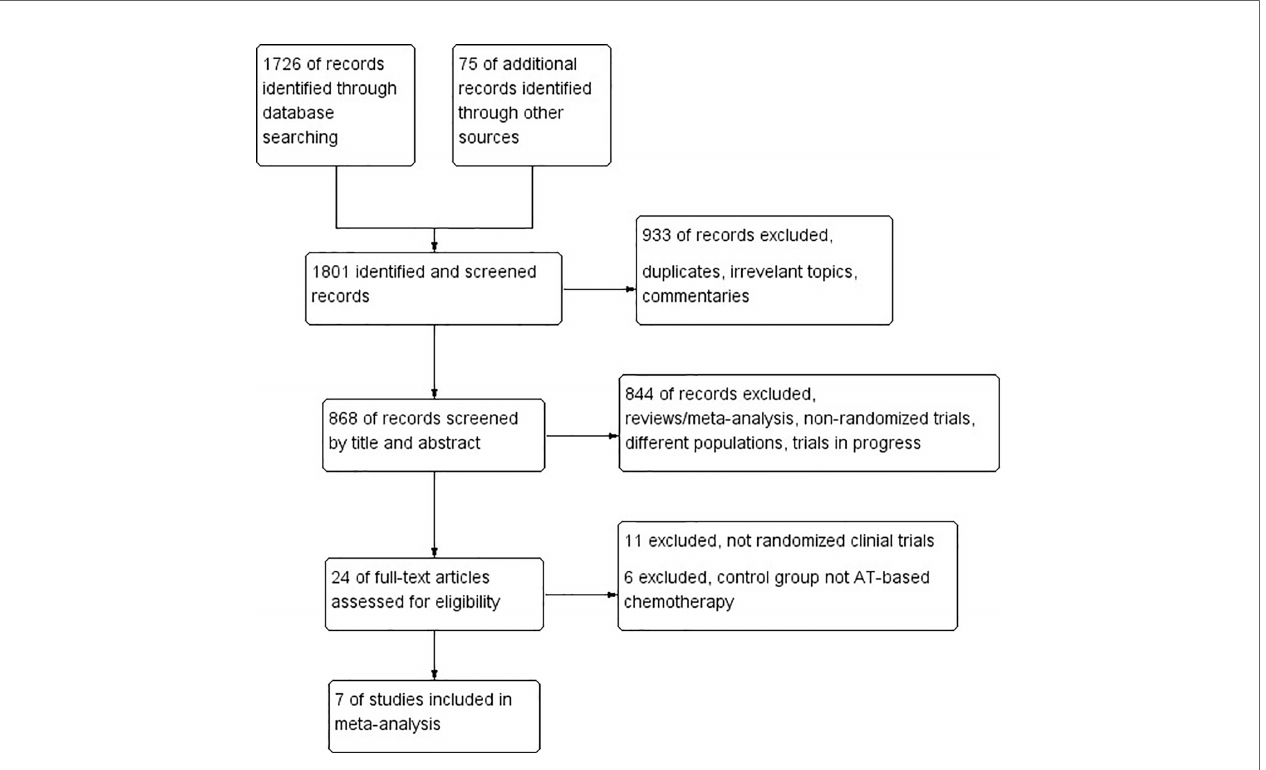
FIGURE 1 | PRISMA fl ow chart summarizing the process for the identi fi cation of eligible randomized controlled